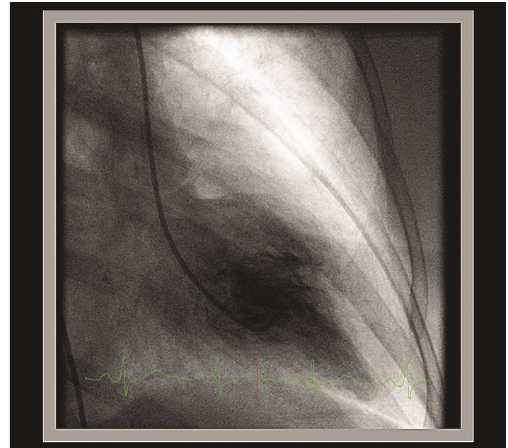
Figure 4: Left ventricular angiogram showing the “ace of spades” appearance of left ventricular contractile function, with basal hypokinesis and normal apex, consistent with reverse Takotsubo